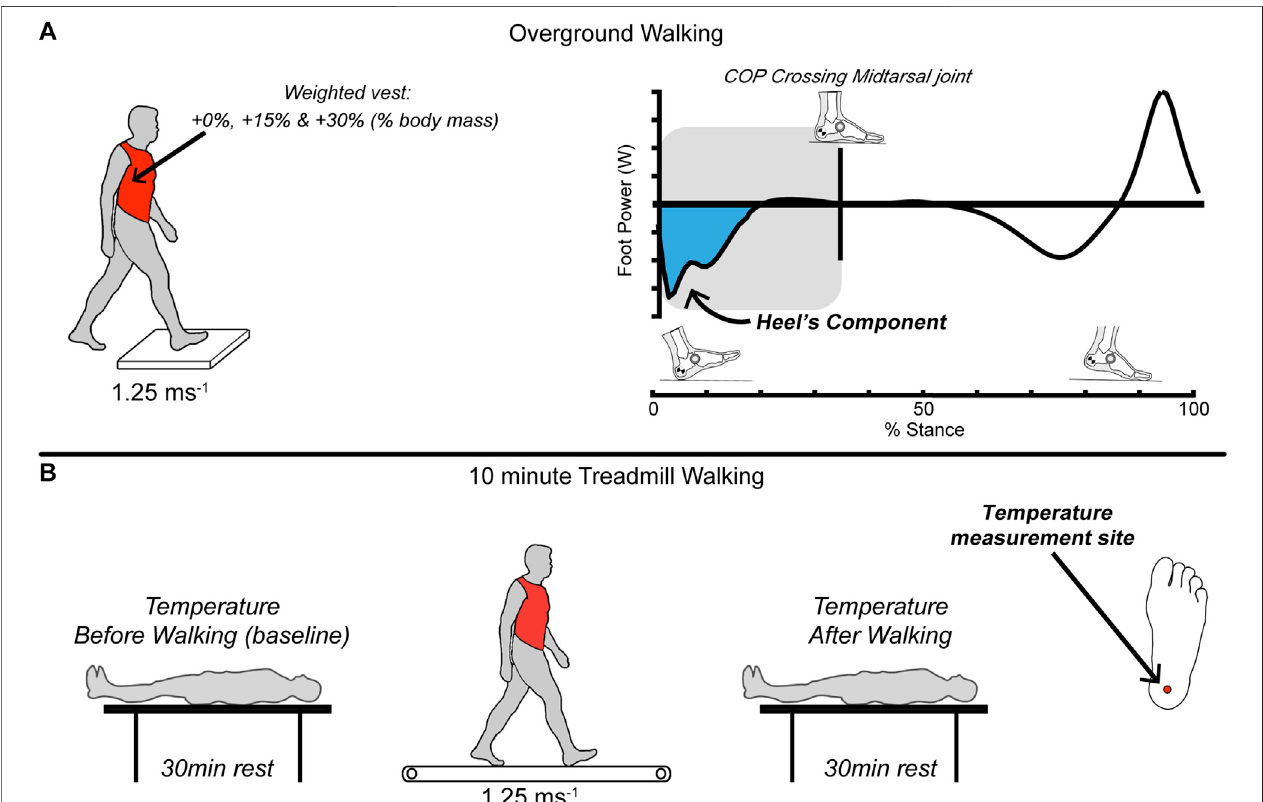
FIGURE1 | A total of20healthy young adults (N =20) completed twobarefoot randomized walking protocols: (A) overground on force plates and (B) 10 min on a treadmill(bothat1.25 m s − 1 ).Participantscarried( via weightvest)threedifferentrandomizedlevelsofsymmetricalloads:+0%;noaddedbodymass,+15%,and+30% oftheirbodymass.Weusedtheovergroundwalkingtrialstocollectfootmechanicsdata(kinematic&kinetic),whereasthetreadmilltrialsmeasuredthefoottemperature data. We quanti fi ed the mechanical power and work done by the foot using a uni fi ed-deformable analysis. We computed the work when the center-of-pressure was underneath the heel segment during the early stance phase to isolate the heel contribution. An estimate of the total work over the 10 min of treadmill walking was calculated by multiplying the average work per step measured in overground trials by the number of steps taken in 10 min of treadmill walking. Temperature measurements were taken immediately before and after each treadmill trial at the bottom of the right foot, including the heel pad. We computed the change in temperature of the heel before and after each walking